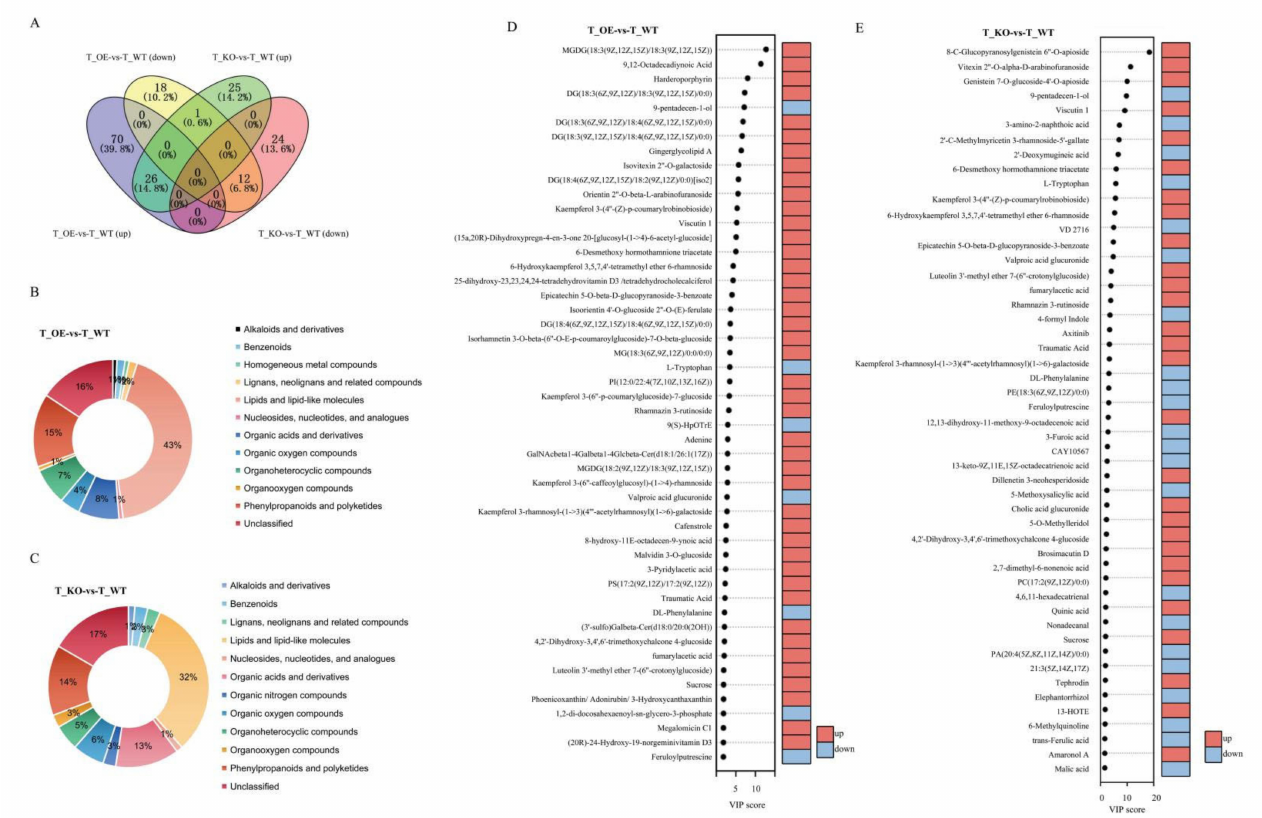
Figure 7. Important differentially expressed metabolites (DEM) identified by partial least squares–discriminant analysis (PLS–DA) in overexpression and CRISPR/Cas9 knockout lines, compared with wild-type plants. ( A ) Overlap of up and downregulated DEMs between OsGA2ox8 overexpression and CRISPR/Cas9 knockout lines compared with wild-type plants under osmotic stress. ( B ) Classification of DEMs between an OsGA2ox8 overexpression line and the wild type. ( C ) Classification of DEMs between an OsGA2ox8 CRISPR/Cas9 knockout line and the wild type. ( D ) Fifty top DEMs according to the variable importance in projection (VIP) scores in an OsGA2ox8 overexpression line compared with the wild type. ( E ) Fifty top DEMs according to the VIP score in a CRISPR/Cas9 knockout line compared with the wild